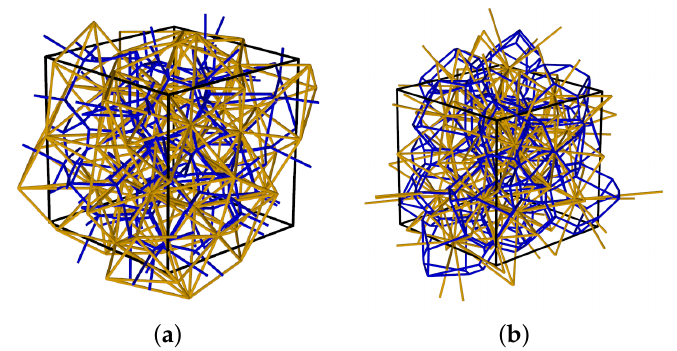
Figure 6. Periodic cell: ( a ) transport elements (blue) with cross-section structural elements (yellow) and ( b ) structural elements (yellow) with cross-section transport elements (blue). For the reference of the colours, the reader is referred to the online version of the